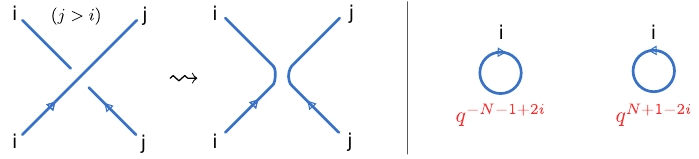
Figure 3 . Left: resolving a labeled knot diagram. Right: multiplicative weights associated to winding of loops.